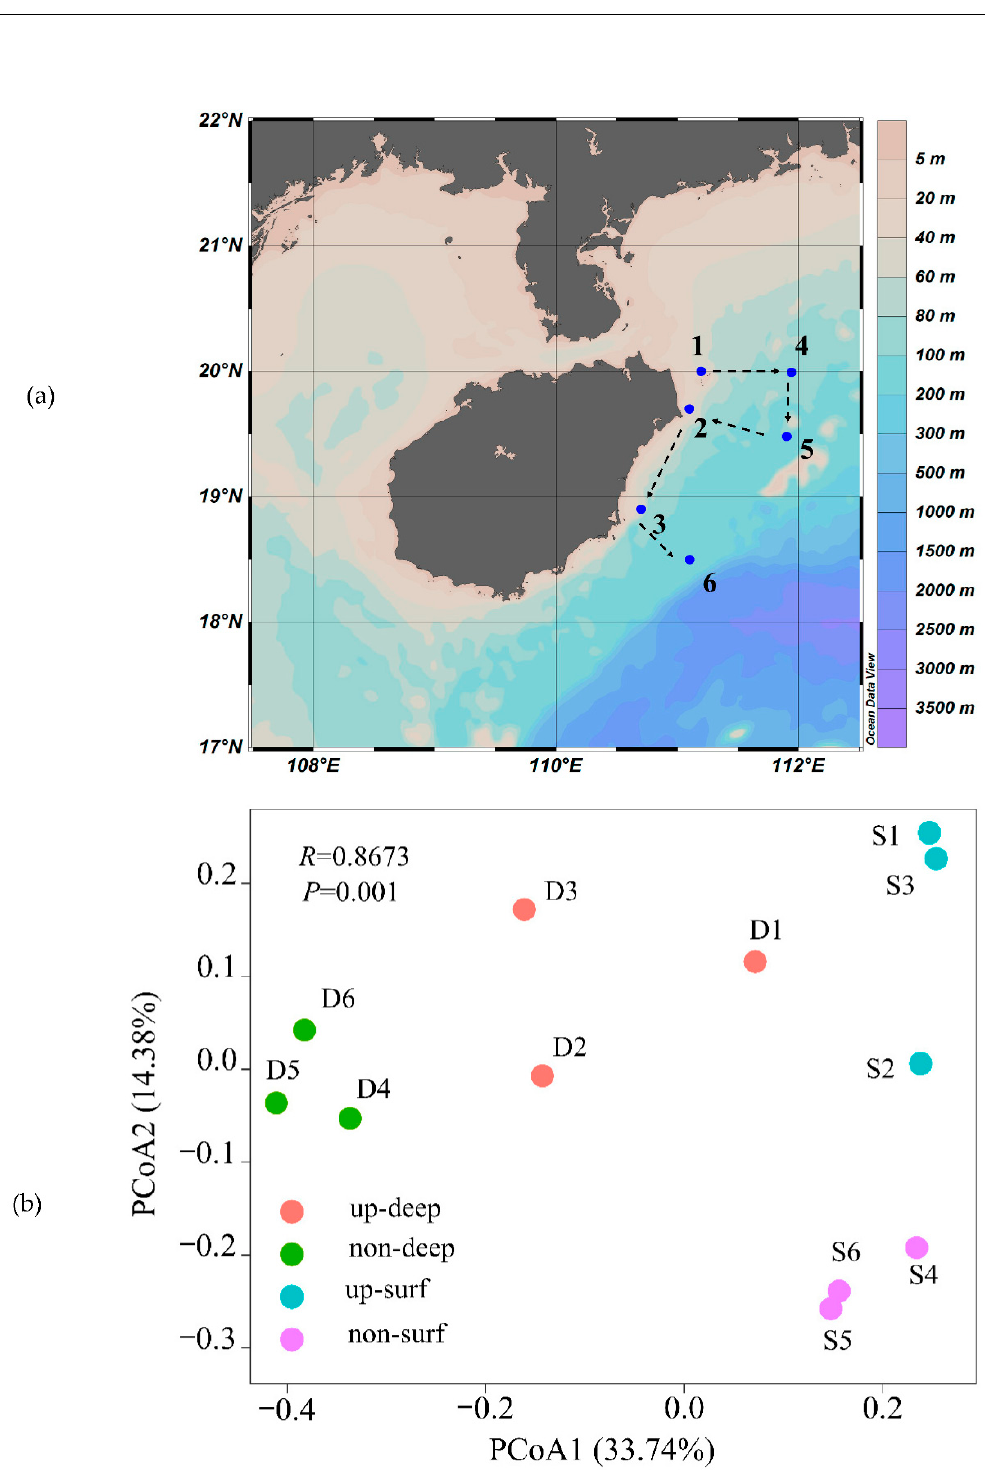
Figure 1. ( a ) Map of the sampling stations in the South China Sea. The shipping route is shown in black dotted arrows. Stations 1, 2, and 3 were in the upwelling area, whereas stations 4, 5, and 6 were in the non-upwelling area. ( b ) PCoA plot based on unweighted UniFrac distance among the bacterial communities from different habitats. The non-upwelling deep water, non-upwelling surface water, upwelling deep water, and upwelling surface water are represented by non-deep, non-surf, up-deep, and up-surf, respectively. S and D indicate surface water and deep water, respectively. The number following S or D indicates the sampling station.